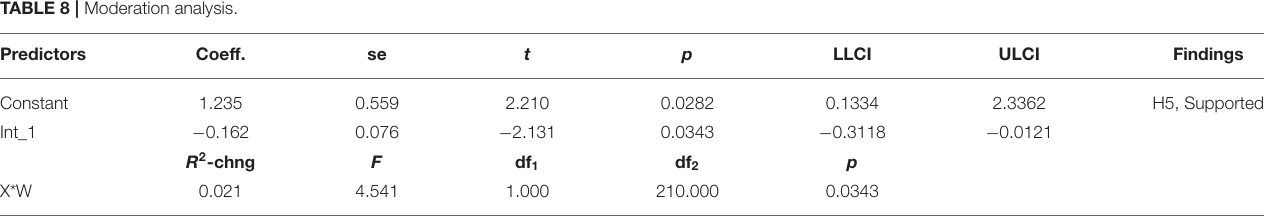
TABLE 8 | Moderation